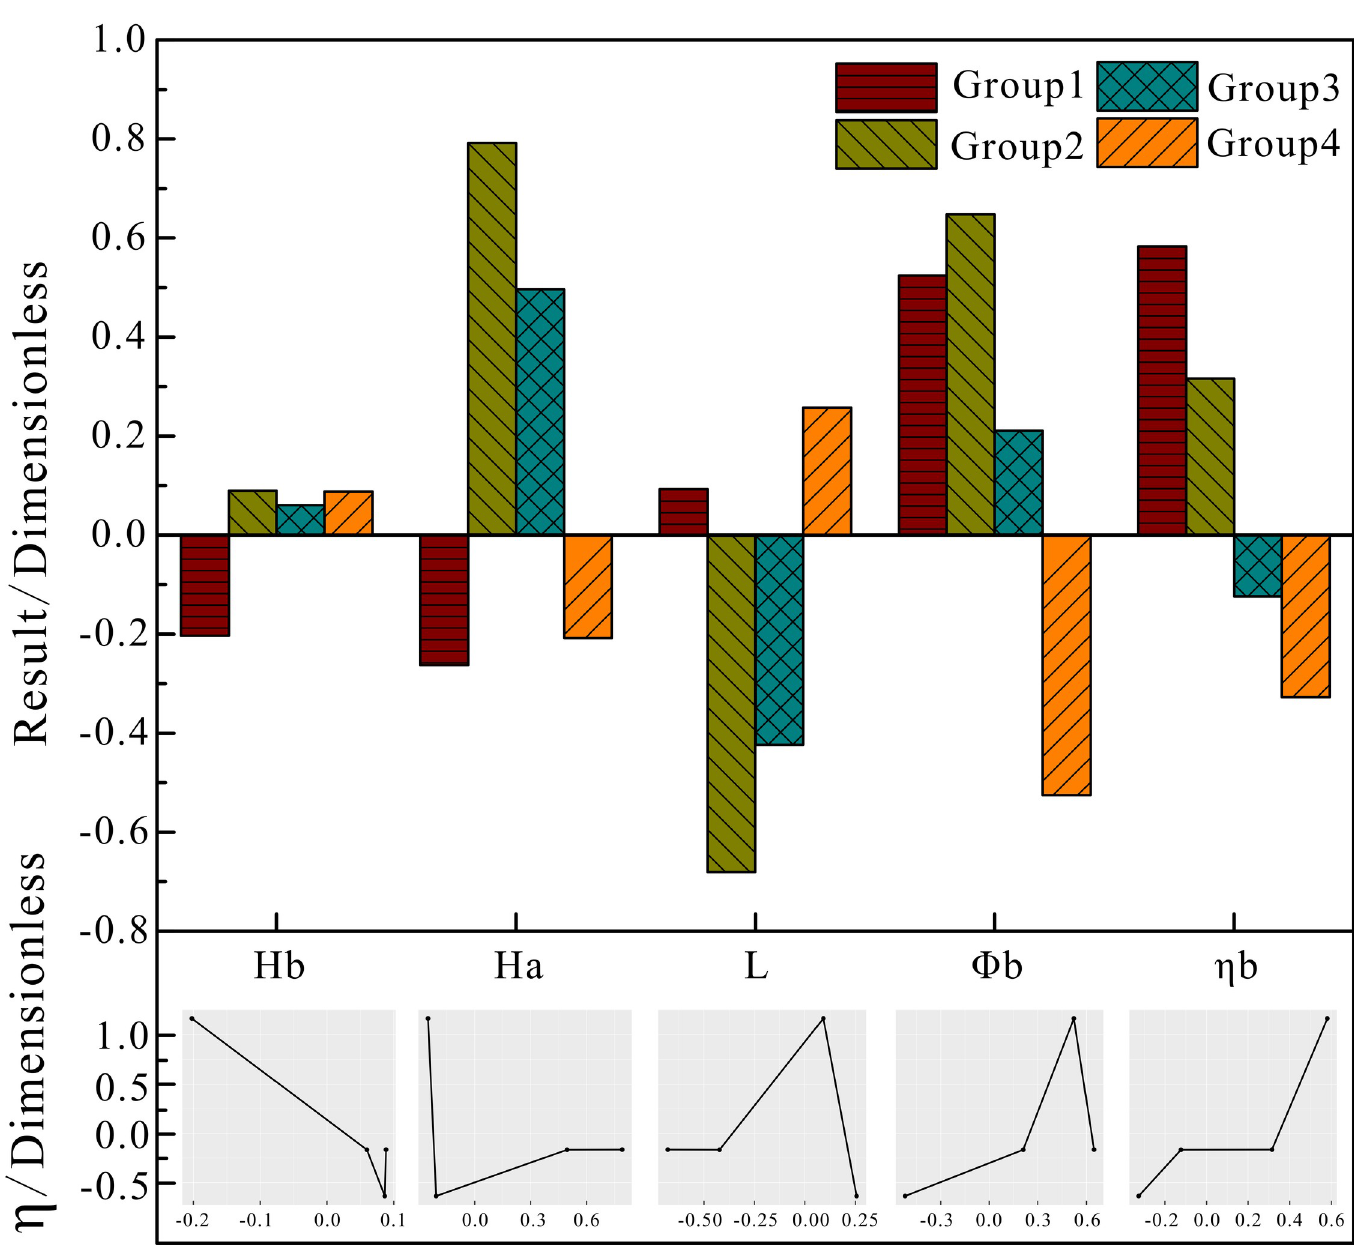
Fig 10. Block downhole parameters of the improved algorithm cluster